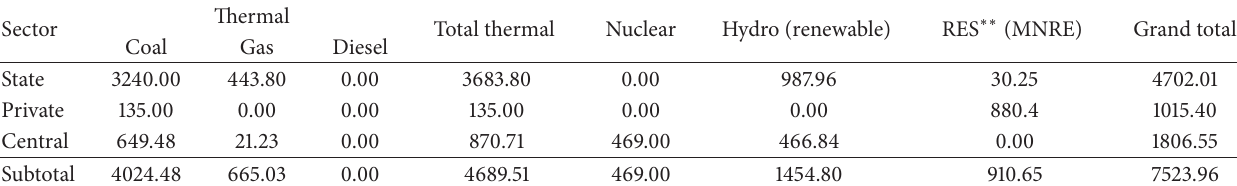
Table 1: Installed capacity of electricity generation in Rajasthan state.